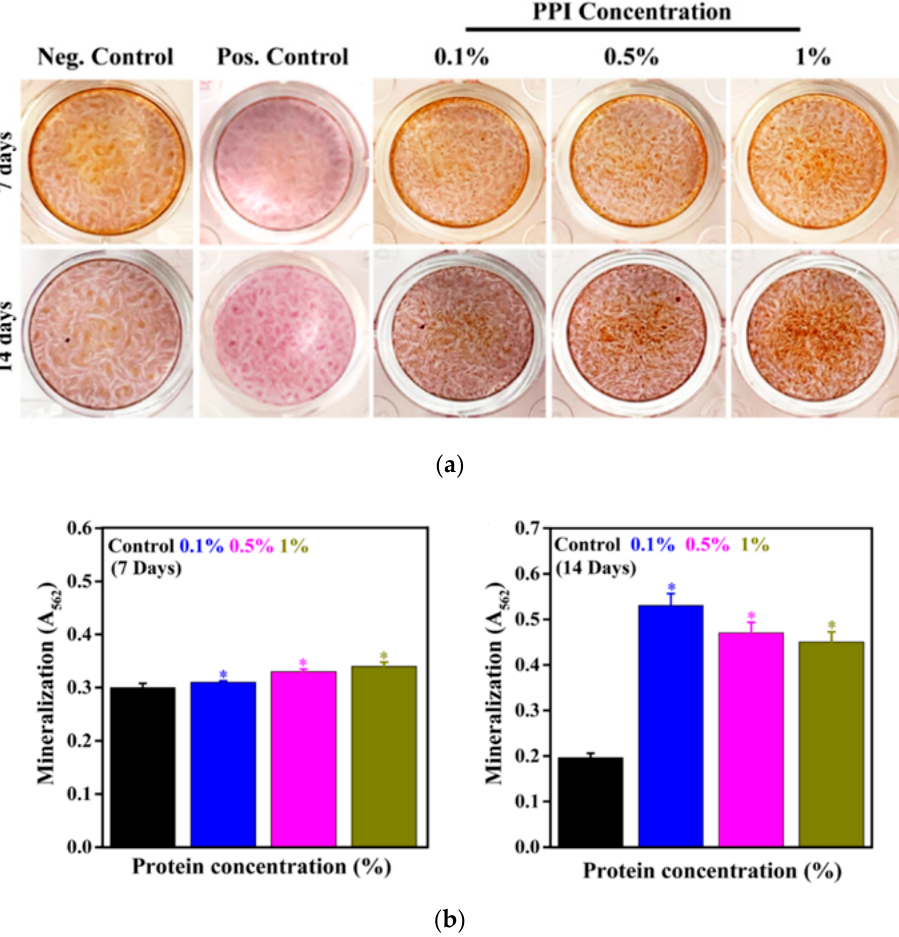
Figure 8. Evaluation of the in vitro mineralization of hBMSCs in the presence of PPI. ( a ) ARS staining of PPI-treated hBMSCs after seven and 14 days of incubation. ( b ) Mineralization potential of hBMSCs at indicated time intervals. Data are the mean ± SD of triplicated experiments; statistical significance at * p < 0.05.